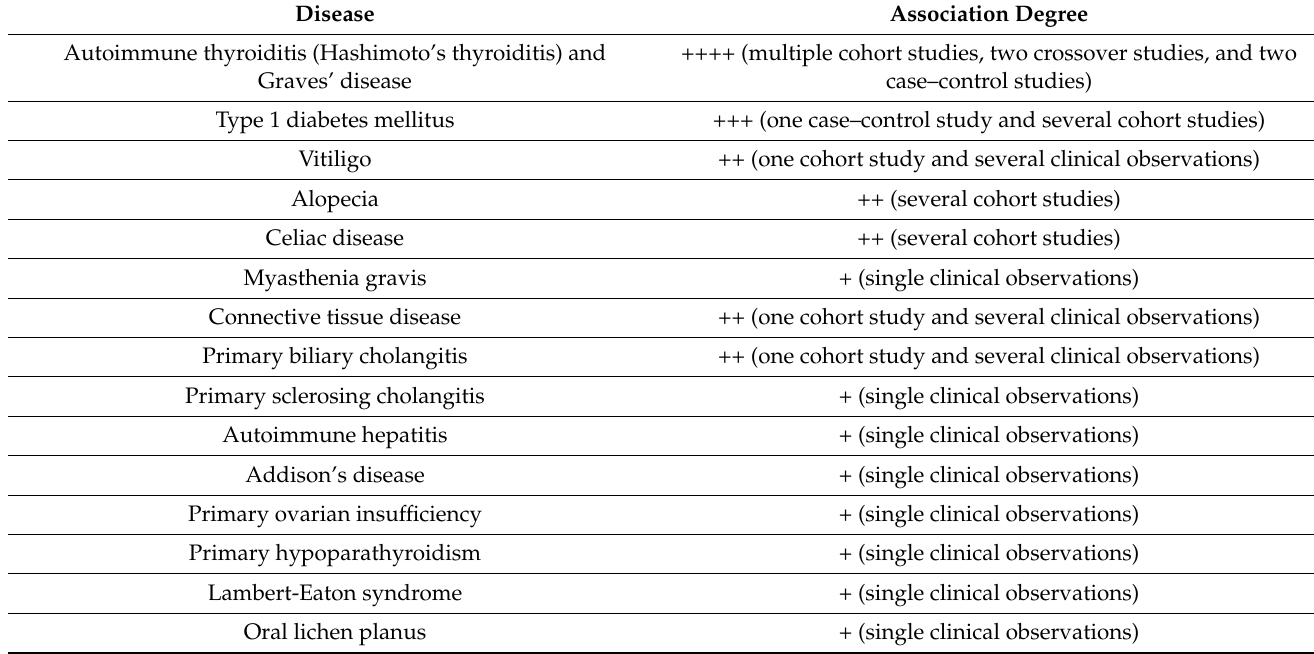
Table 3. Autoimmune diseases associated with autoimmune gastritis (adapted from Massironi et al., 2019). Disease Association Degree Autoimmune thyroiditis (Hashimoto’s thyroiditis) and Graves’